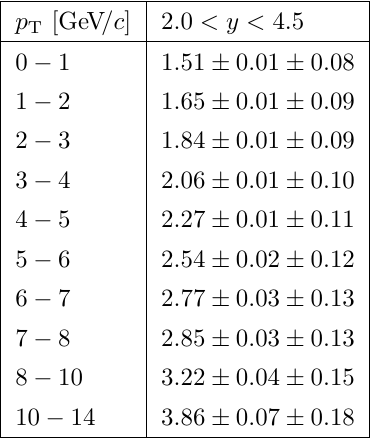
Table 12 . Cross-section ratios between 13 TeV and 5 TeV measurements for prompt J/ψ mesons as a function of p T with 2 . 0 < y < 4 . 5 . The first uncertainty is statistical and the second is systematic.